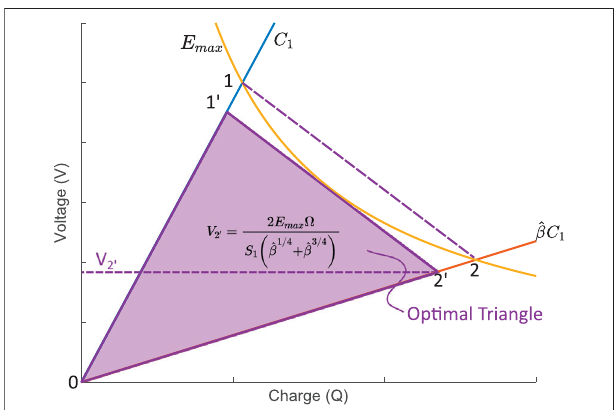
FIGURE 3 | The optimal (OT) cycle is de fi ned using a line linking the intersection of the maximal fi eld line with the C 1 isocapacitance line (point 1), and with the ^ β C 1 isocapacitance line (point 2). This line is then shifted until it becomes tangent with the maximal electric fi eld limit to form line 1 ′ -2 ’ . The purple rectangle shows the net energy produced for each